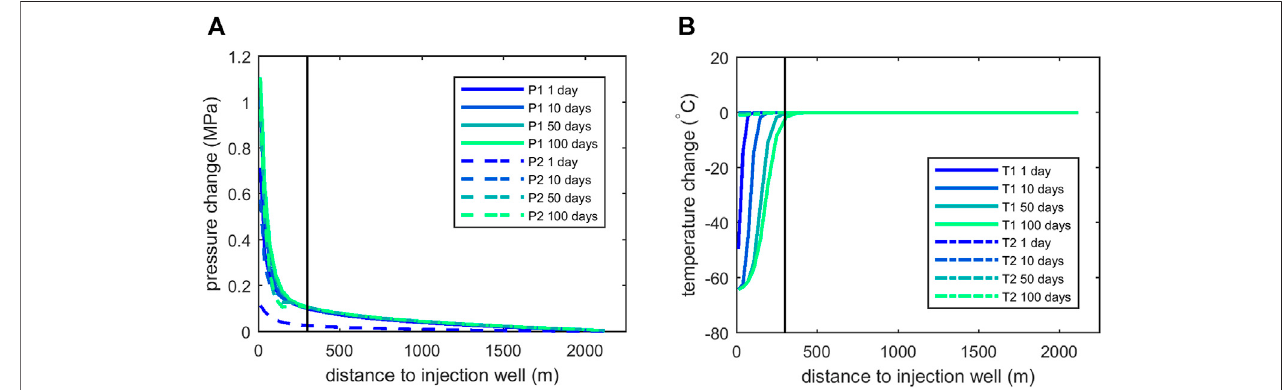
FIGURE 2 | (A) Short-term pressure evolution during fi rst 100 days after onset injection; 200 m fracture spacing, (B) short-term temperature evolution during fi rst 100 days after onset injection; 200 m fracture spacing. Solid lines (T 1 , P 1 ) indicate values in the fractures, dashed lines (T 2 , P 2 ) in the matrix. The black vertical line represents the horizontal position of the fault, measured at mid-height reservoir level.